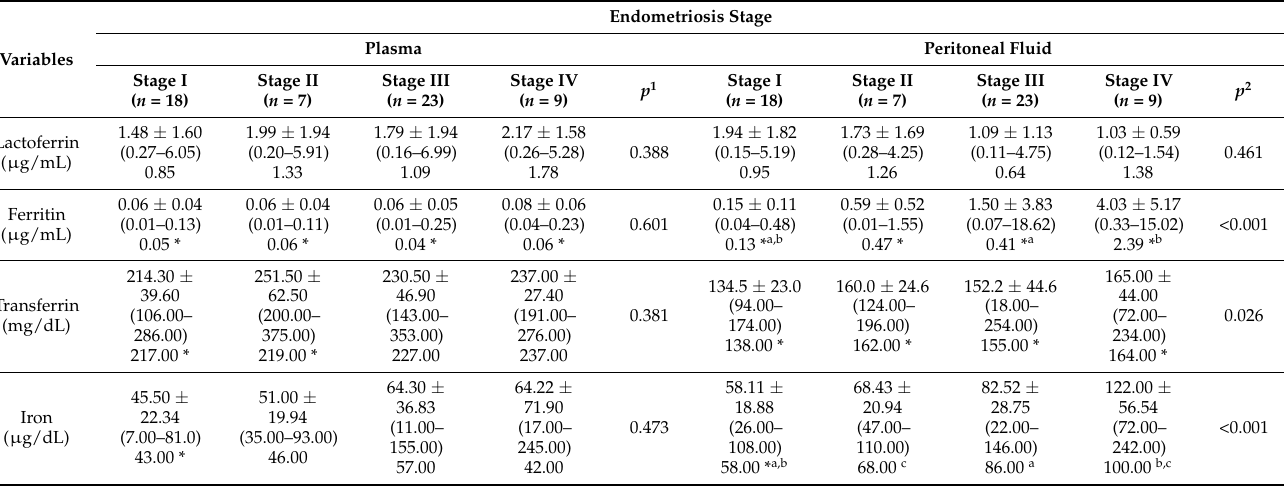
Table 3. Comparison of lactoferrin, ferritin, transferrin and iron concentrations in serum and peri- toneal fluid between different endometriosis stages.